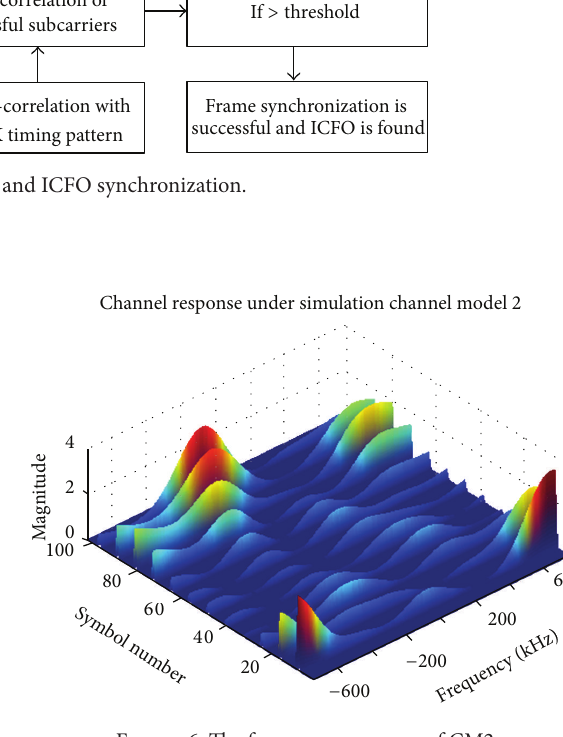
Figure 5: The frequency response of CM1. Figure 6: The frequency response of